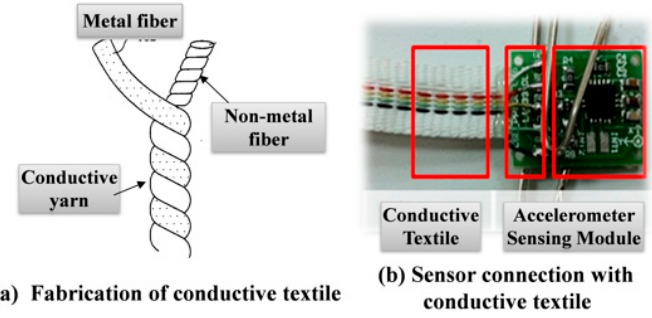
Figure 2. Conductive textile: ( a ) fabrication schematics; and ( b ) integrated with sensing module.